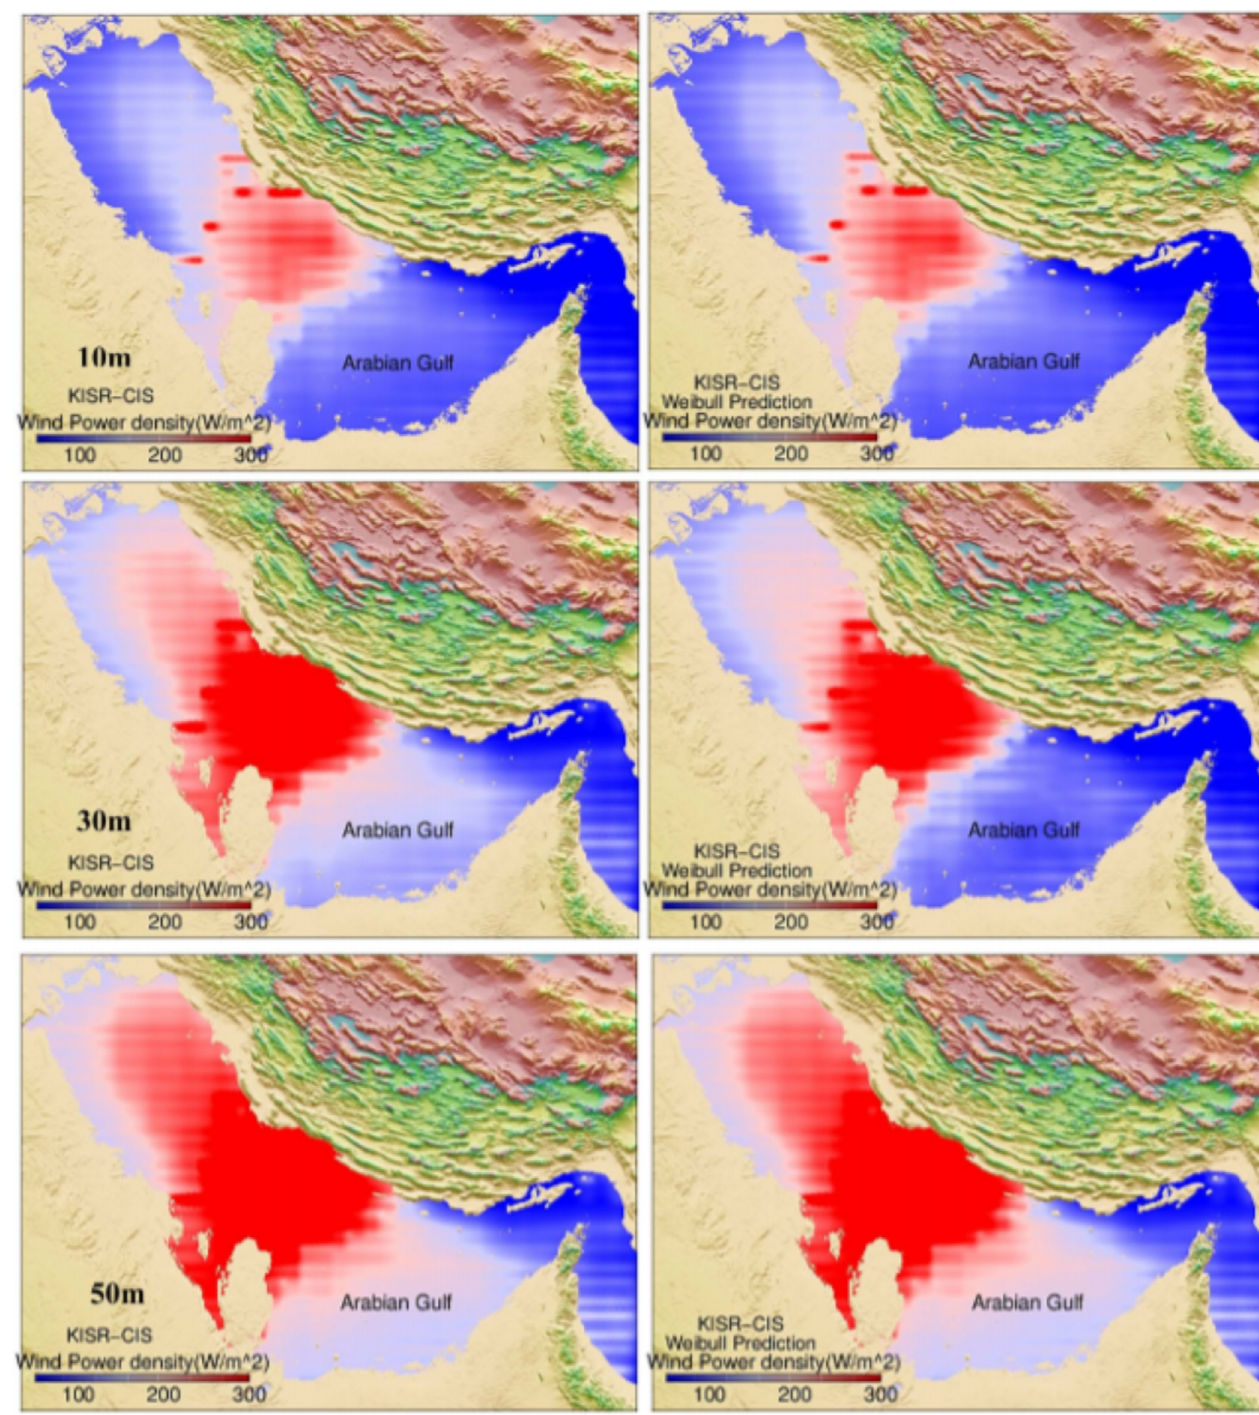
Fig. 2. Comparison of Weibull predicted and actual distribution of wind power density (Wm (cid:1) 2 ) at 10, 30 and 50 m over Arabian Gulf Waters for periods of (1979 – 2015)